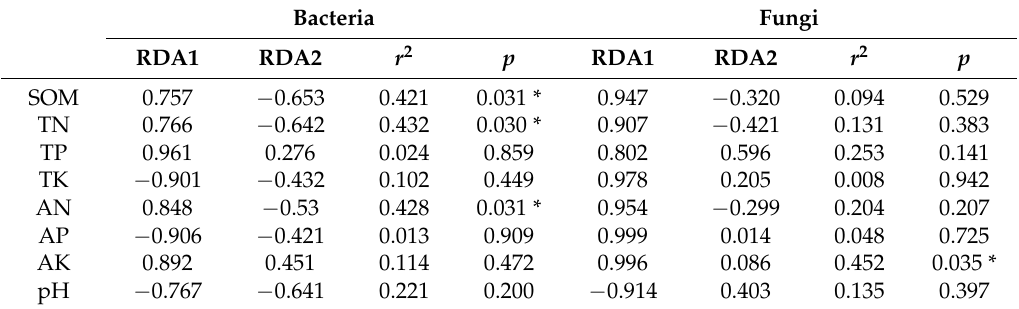
The r 2 indicates the proportion of variance explained. ** ( p < 0.01) and * ( p < 0.05) indicate significant differences among values of soil sample parameters based on a one-way ANOVA followed by an least significant difference (LSD) test. SOM indicates soil organic matter; TN indicates total nitrogen; TP indicates total phosphorus; TK indicates total potassium; AN indicates available nitrogen; AP indicates available phosphorus; AK indicates available